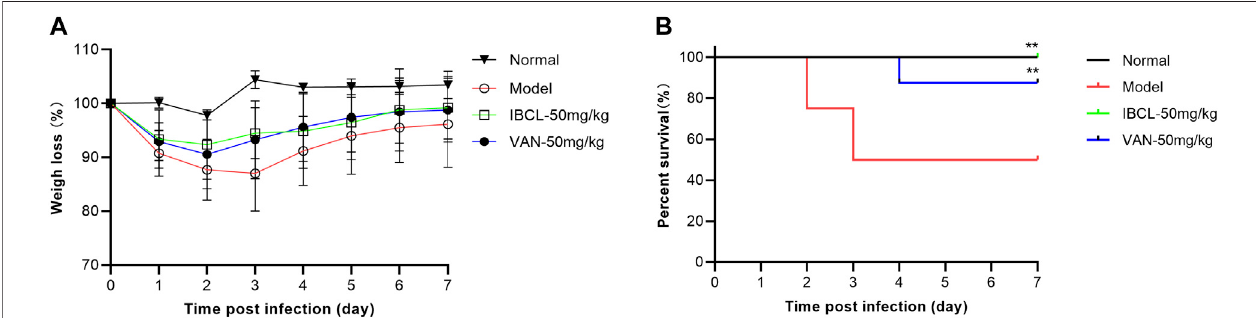
FIGURE7| IBCLisprotective invivo onmiceCDImodel. (A) Weightslossofmiceafterchallengewith C.dif fi cile (10 5 CFU/ml)onday0today7. (B) Mousesurvival as determined by a log-rank/Mantel – Cox test. ** p < 0.01 using one-way ANOVA. Data represent the eight mice/group.